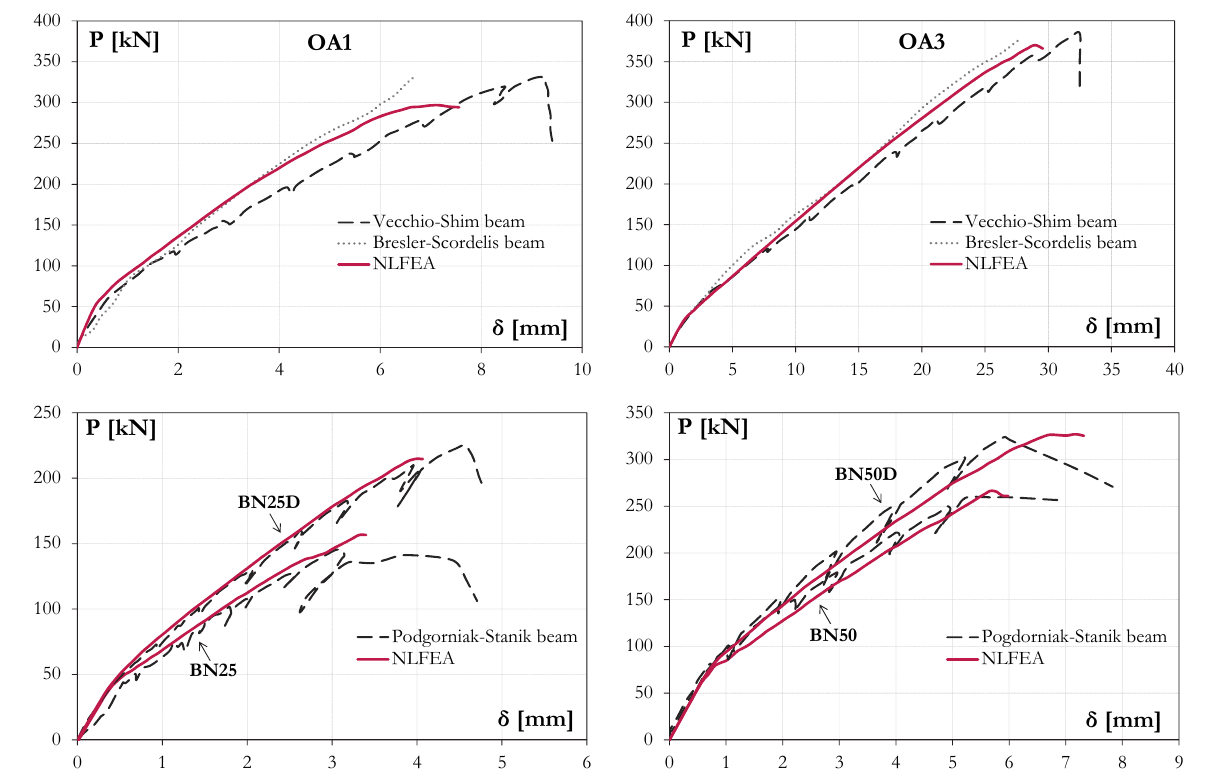
Figure 4: Comparison between experimental and numerical results in terms of applied load vs. midspan deflection for specimens (a), (b) of the OA series [17], and (c), (d) of the BN series [18].